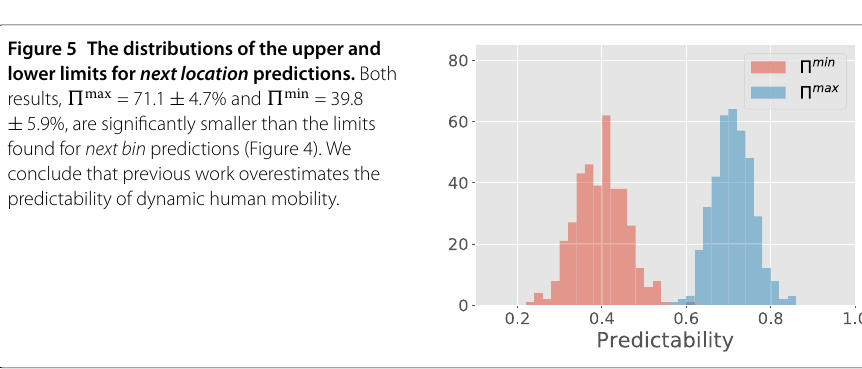
Figure 5 The distributions of the upper and lower limits for nextlocation predictions. Both results, (cid:2) max = 71.1 ± 4.7% and (cid:2) min = 39.8 ± 5.9%, are significantly smaller than the